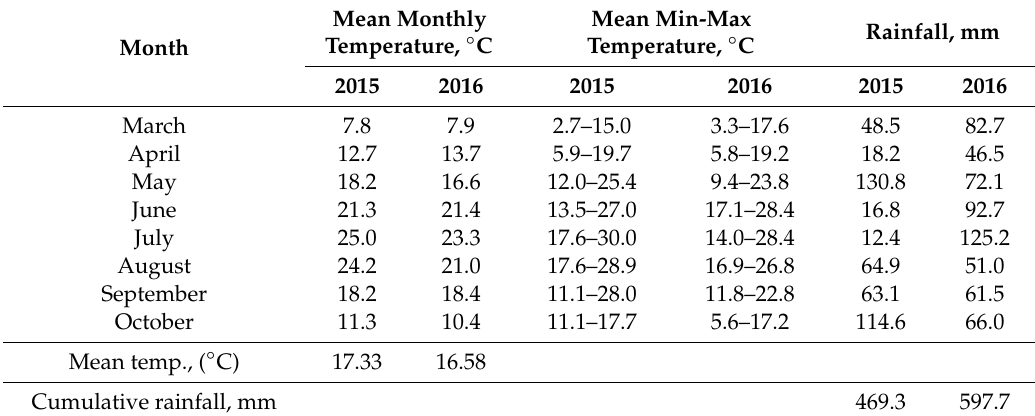
Table 5. Rainfall and mean temperatures in Đ akovo from March to October in 2015 and